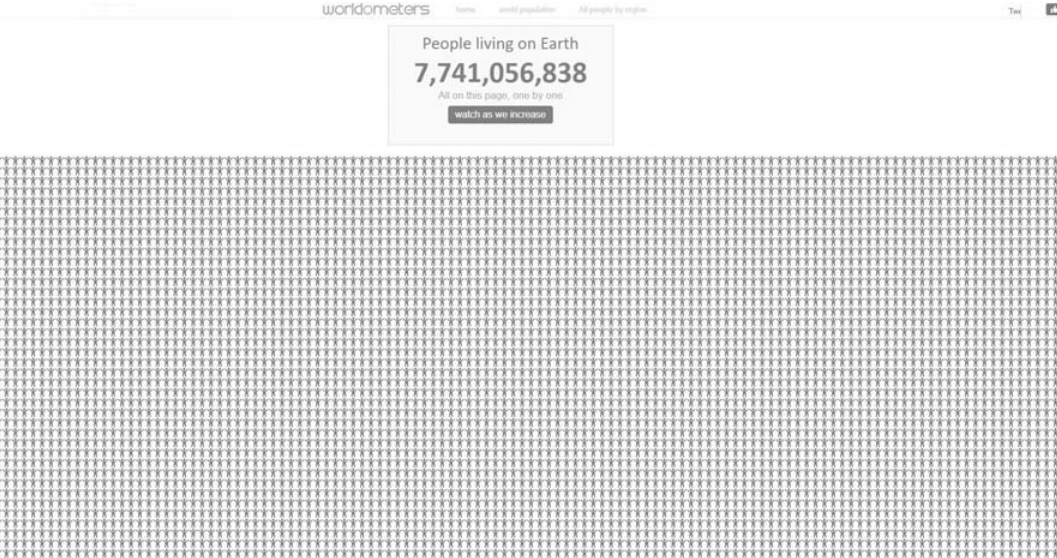
Figure 10. (cid:3) (cid:40)(cid:86)(cid:87)(cid:76)(cid:80)(cid:68)(cid:87)(cid:72)(cid:71)(cid:3) (cid:83)(cid:82)(cid:83)(cid:88)(cid:79)(cid:68)(cid:87)(cid:76)(cid:82)(cid:81)(cid:3) (cid:76)(cid:81)(cid:3) (cid:87)(cid:75)(cid:72)(cid:3) (cid:90)(cid:82)(cid:85)(cid:79)(cid:71)(cid:3) (cid:76)(cid:81)(cid:70)(cid:79)(cid:88)(cid:71)(cid:76)(cid:81)(cid:74)(cid:3) (cid:89)(cid:76)(cid:86)(cid:88)(cid:68)(cid:79)(cid:76)(cid:93)(cid:68)(cid:87)(cid:76)(cid:82)(cid:81)(cid:3) (cid:82)(cid:73)(cid:3) (cid:76)(cid:87)(cid:86)(cid:3) (cid:81)(cid:88)(cid:80)(cid:69)(cid:72)(cid:85) (cid:54)(cid:82)(cid:88)(cid:85)(cid:70)(cid:72)(cid:29)(cid:3)(cid:75)(cid:87)(cid:87)(cid:83)(cid:86)(cid:29)(cid:18)(cid:18)(cid:90)(cid:90)(cid:90)(cid:17)(cid:90)(cid:82)(cid:85)(cid:79)(cid:71)(cid:82)(cid:80)(cid:72)(cid:87)(cid:72)(cid:85)(cid:86)(cid:17)(cid:76)(cid:81)(cid:73)(cid:82)(cid:18)(cid:90)(cid:68)(cid:87)(cid:70)(cid:75)(cid:18)(cid:90)(cid:82)(cid:85)(cid:79)(cid:71)(cid:16)(cid:83)(cid:82)(cid:83)(cid:88)(cid:79)(cid:68)(cid:87)(cid:76)(cid:82)(cid:81)(cid:18) (cid:37)(cid:68)(cid:86)(cid:72)(cid:71)(cid:3)(cid:82)(cid:81)(cid:3)(cid:87)(cid:75)(cid:76)(cid:86)(cid:3)(cid:71)(cid:68)(cid:87)(cid:68)(cid:3)(cid:68)(cid:81)(cid:71)(cid:3)(cid:86)(cid:88)(cid:85)(cid:89)(cid:72)(cid:92)(cid:3)(cid:85)(cid:72)(cid:86)(cid:88)(cid:79)(cid:87)(cid:86)(cid:15)(cid:3)(cid:87)(cid:75)(cid:72)(cid:3)(cid:83)(cid:82)(cid:83)(cid:88)(cid:79)(cid:68)(cid:85)(cid:76)(cid:87)(cid:92)(cid:3)(cid:11)(cid:88)(cid:86)(cid:76)(cid:81)(cid:74)(cid:3)(cid:86)(cid:82)(cid:70)(cid:76)(cid:68)(cid:79)(cid:3)(cid:80)(cid:72)(cid:71)(cid:76)(cid:68)(cid:12)(cid:3) (cid:68)(cid:86)(cid:3)(cid:90)(cid:72)(cid:79)(cid:79)(cid:3)(cid:68)(cid:86)(cid:3)(cid:87)(cid:75)(cid:72)(cid:3)(cid:72)(cid:91)(cid:70)(cid:79)(cid:88)(cid:86)(cid:76)(cid:82)(cid:81)(cid:3)(cid:11)(cid:81)(cid:82)(cid:87)(cid:3)(cid:88)(cid:86)(cid:76)(cid:81)(cid:74)(cid:3)(cid:86)(cid:82)(cid:70)(cid:76)(cid:68)(cid:79)(cid:3)(cid:80)(cid:72)(cid:71)(cid:76)(cid:68)(cid:12)(cid:3)(cid:70)(cid:82)(cid:72)(cid:73)(cid:192)(cid:70)(cid:76)(cid:72)(cid:81)(cid:87)(cid:3)(cid:90)(cid:72)(cid:85)(cid:72)(cid:3)(cid:70)(cid:68)(cid:79)(cid:70)(cid:88)(cid:79)(cid:68)(cid:87)(cid:72)(cid:71)(cid:17) (cid:55)(cid:75)(cid:72)(cid:3)(cid:83)(cid:82)(cid:83)(cid:88)(cid:79)(cid:68)(cid:85)(cid:76)(cid:87)(cid:92)(cid:3)(cid:70)(cid:82)(cid:72)(cid:73)(cid:192)(cid:70)(cid:76)(cid:72)(cid:81)(cid:87)(cid:3)(cid:11)(cid:76)(cid:81)(cid:70)(cid:79)(cid:88)(cid:86)(cid:76)(cid:82)(cid:81)(cid:3)(cid:82)(cid:73)(cid:3)(cid:68)(cid:3)(cid:88)(cid:86)(cid:72)(cid:85)(cid:3)(cid:76)(cid:81)(cid:3)(cid:86)(cid:82)(cid:70)(cid:76)(cid:68)(cid:79)(cid:3)(cid:80)(cid:72)(cid:71)(cid:76)(cid:68)(cid:15)(cid:3)(cid:76)(cid:81)(cid:89)(cid:82)(cid:79)(cid:89)(cid:72)(cid:80)(cid:72)(cid:81)(cid:87)(cid:3) (cid:76)(cid:81)(cid:3)(cid:83)(cid:82)(cid:83)(cid:88)(cid:79)(cid:68)(cid:85)(cid:76)(cid:87)(cid:92)(cid:12)(cid:3)(cid:85)(cid:72)(cid:83)(cid:85)(cid:72)(cid:86)(cid:72)(cid:81)(cid:87)(cid:86)(cid:3)(cid:87)(cid:75)(cid:72)(cid:3)(cid:71)(cid:72)(cid:74)(cid:85)(cid:72)(cid:72)(cid:3)(cid:82)(cid:73)(cid:3)(cid:72)(cid:86)(cid:87)(cid:76)(cid:80)(cid:68)(cid:87)(cid:72)(cid:71)(cid:3)(cid:83)(cid:82)(cid:83)(cid:88)(cid:79)(cid:68)(cid:85)(cid:76)(cid:87)(cid:92)(cid:3)(cid:76)(cid:81)(cid:3)(cid:86)(cid:82)(cid:70)(cid:76)(cid:68)(cid:79)(cid:3)(cid:80)(cid:72)(cid:71)(cid:76)(cid:68)(cid:3) (cid:69)(cid:68)(cid:86)(cid:72)(cid:71)(cid:3)(cid:82)(cid:81)(cid:3)(cid:68)(cid:3)(cid:74)(cid:76)(cid:89)(cid:72)(cid:81)(cid:3)(cid:71)(cid:68)(cid:87)(cid:68)(cid:3)(cid:86)(cid:72)(cid:87)(cid:17)(cid:3)(cid:37)(cid:68)(cid:86)(cid:72)(cid:71)(cid:3)(cid:82)(cid:81)(cid:3)(cid:87)(cid:75)(cid:76)(cid:86)(cid:15)(cid:3)(cid:82)(cid:81)(cid:72)(cid:3)(cid:70)(cid:68)(cid:81)(cid:3)(cid:70)(cid:68)(cid:79)(cid:70)(cid:88)(cid:79)(cid:68)(cid:87)(cid:72)(cid:3)(cid:87)(cid:75)(cid:72)(cid:76)(cid:85)(cid:3)(cid:86)(cid:82)(cid:70)(cid:76)(cid:68)(cid:79)(cid:3)(cid:72)(cid:91)(cid:70)(cid:79)(cid:88)(cid:86)(cid:76)(cid:82)(cid:81)(cid:3)